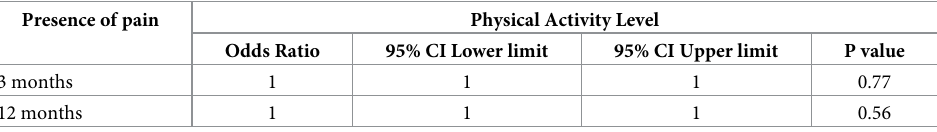
Table 4. Association between physical activity level (total MET minutes per week) before index episode and the presence of low back pain 3 months and 12 months after the index episode (unadjusted